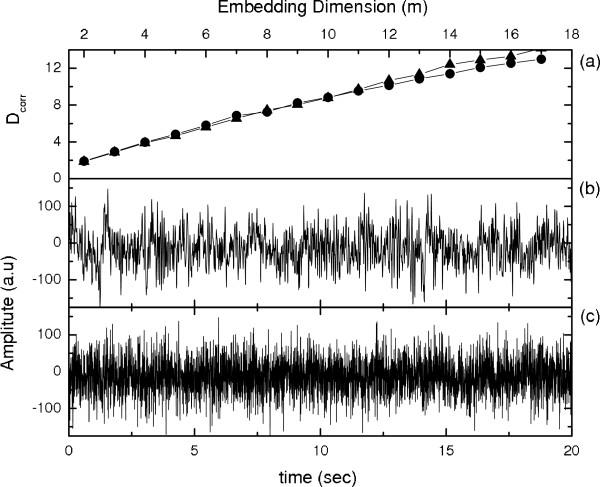
Surrogate analysis for data Set A: (a) Variation of Dcorr with m. Black dot for (b) Original data; and triangle for (c) Surrogate data.